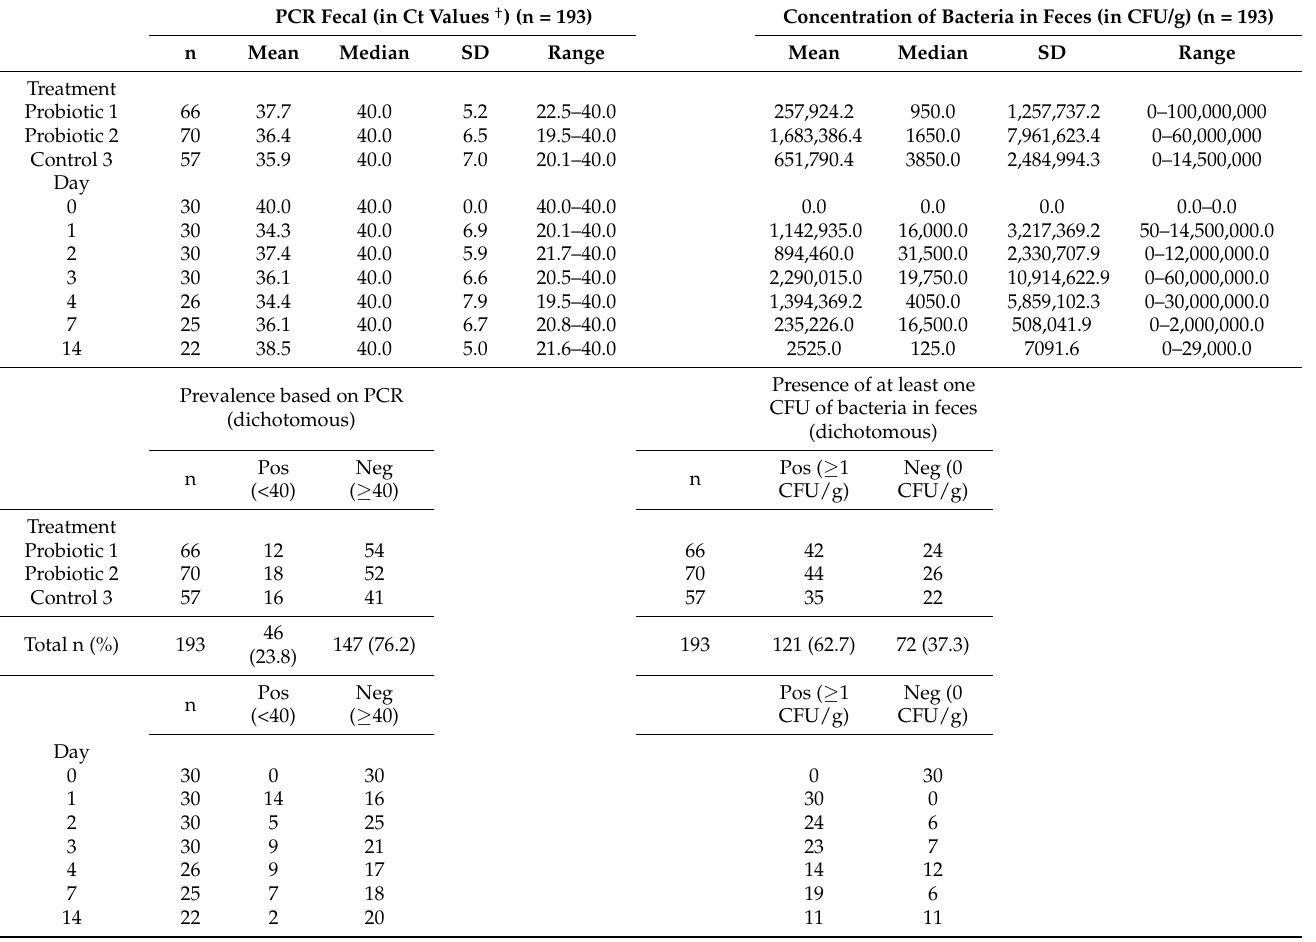
Table 3. PCR results and concentration of C. perfringens in feces on a continuous scale and as dichotomous outcomes (positive vs. negative) by treatment group and study day in dairy calves supplemented with two probiotic products to reduce Clostridium perfringens .